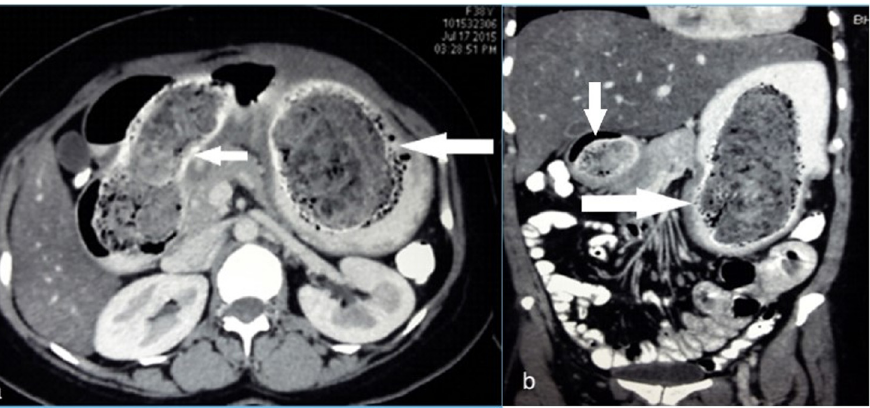
Figure 1: Axial ( a ) and coronal ( b ) CT scan image showing a non - homogenous non - enhancing mass with a mottled appearance within the lumen of the stomach ( large arrow ) fi rst and second part of duodenum ( small arrow )